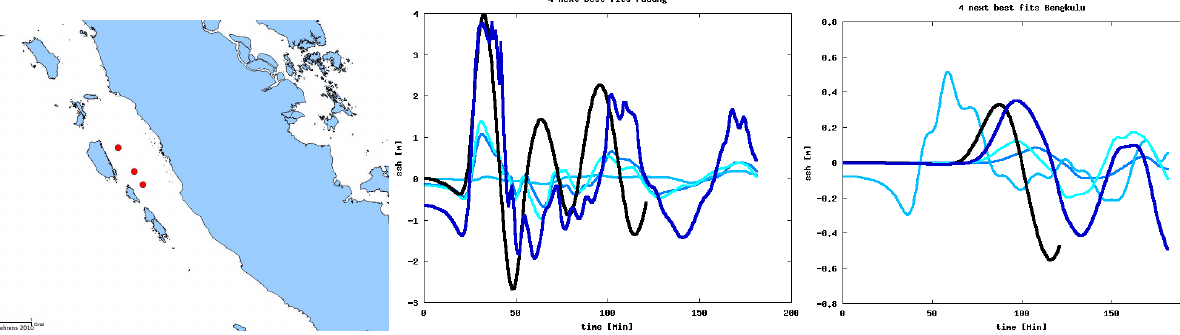
Fig. 12. Benchmark experiment with given seismic parameters and GPS dislocation vectors (see Fig. 9 for description of the three